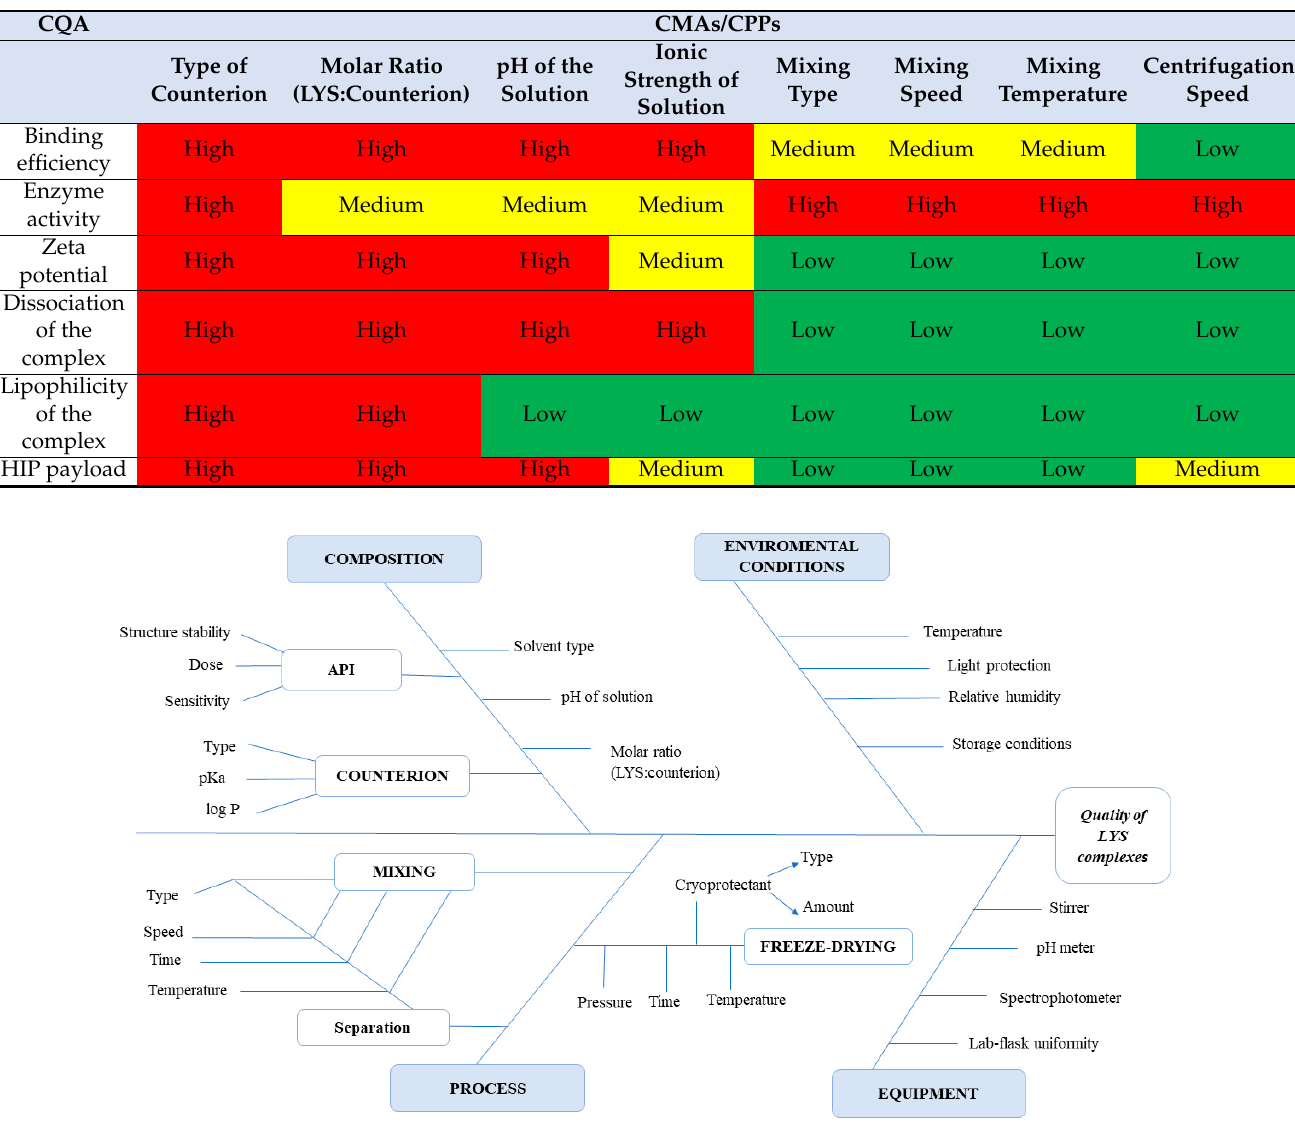
Table 3. Interdependence rating between CMAs/CPPs and CQAs as for the complexation step (red color—high dependence, yellow—medium dependence, green—low dependence).